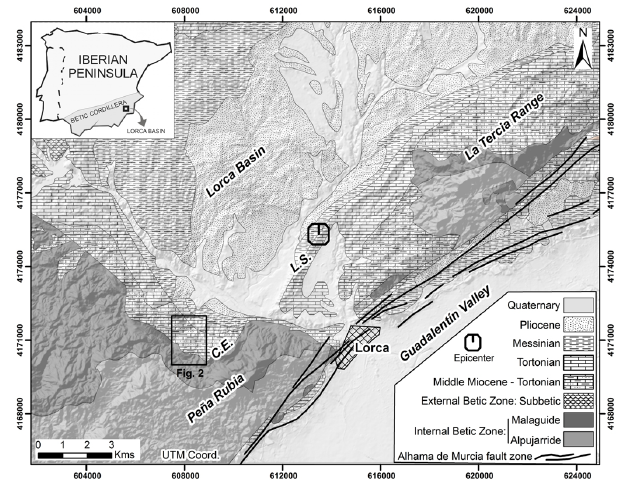
Fig. 1. Location map of the study zone. Location of Fig. 2 is also